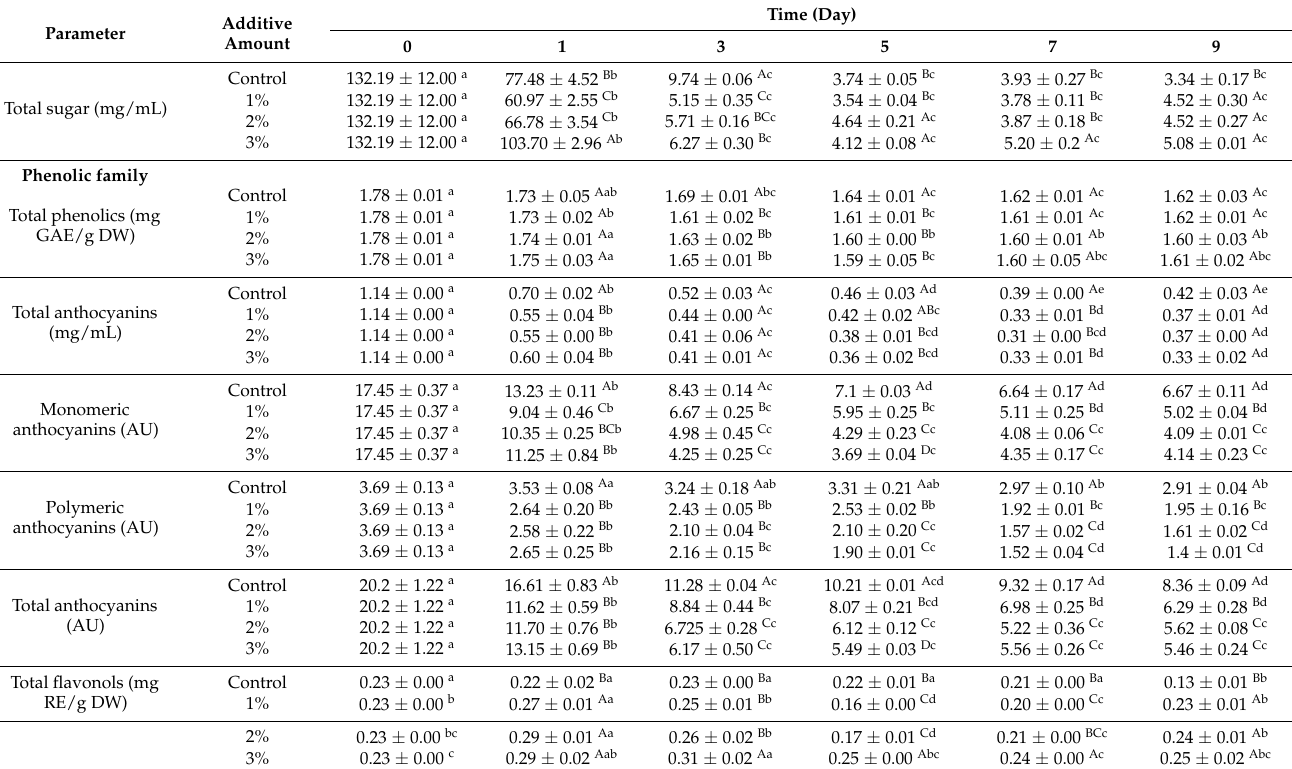
Table 2. Total sugar content, phenolic contents, color and antioxidant activities of mixed mulberry fruit and mulberry leaf fermented alcoholic